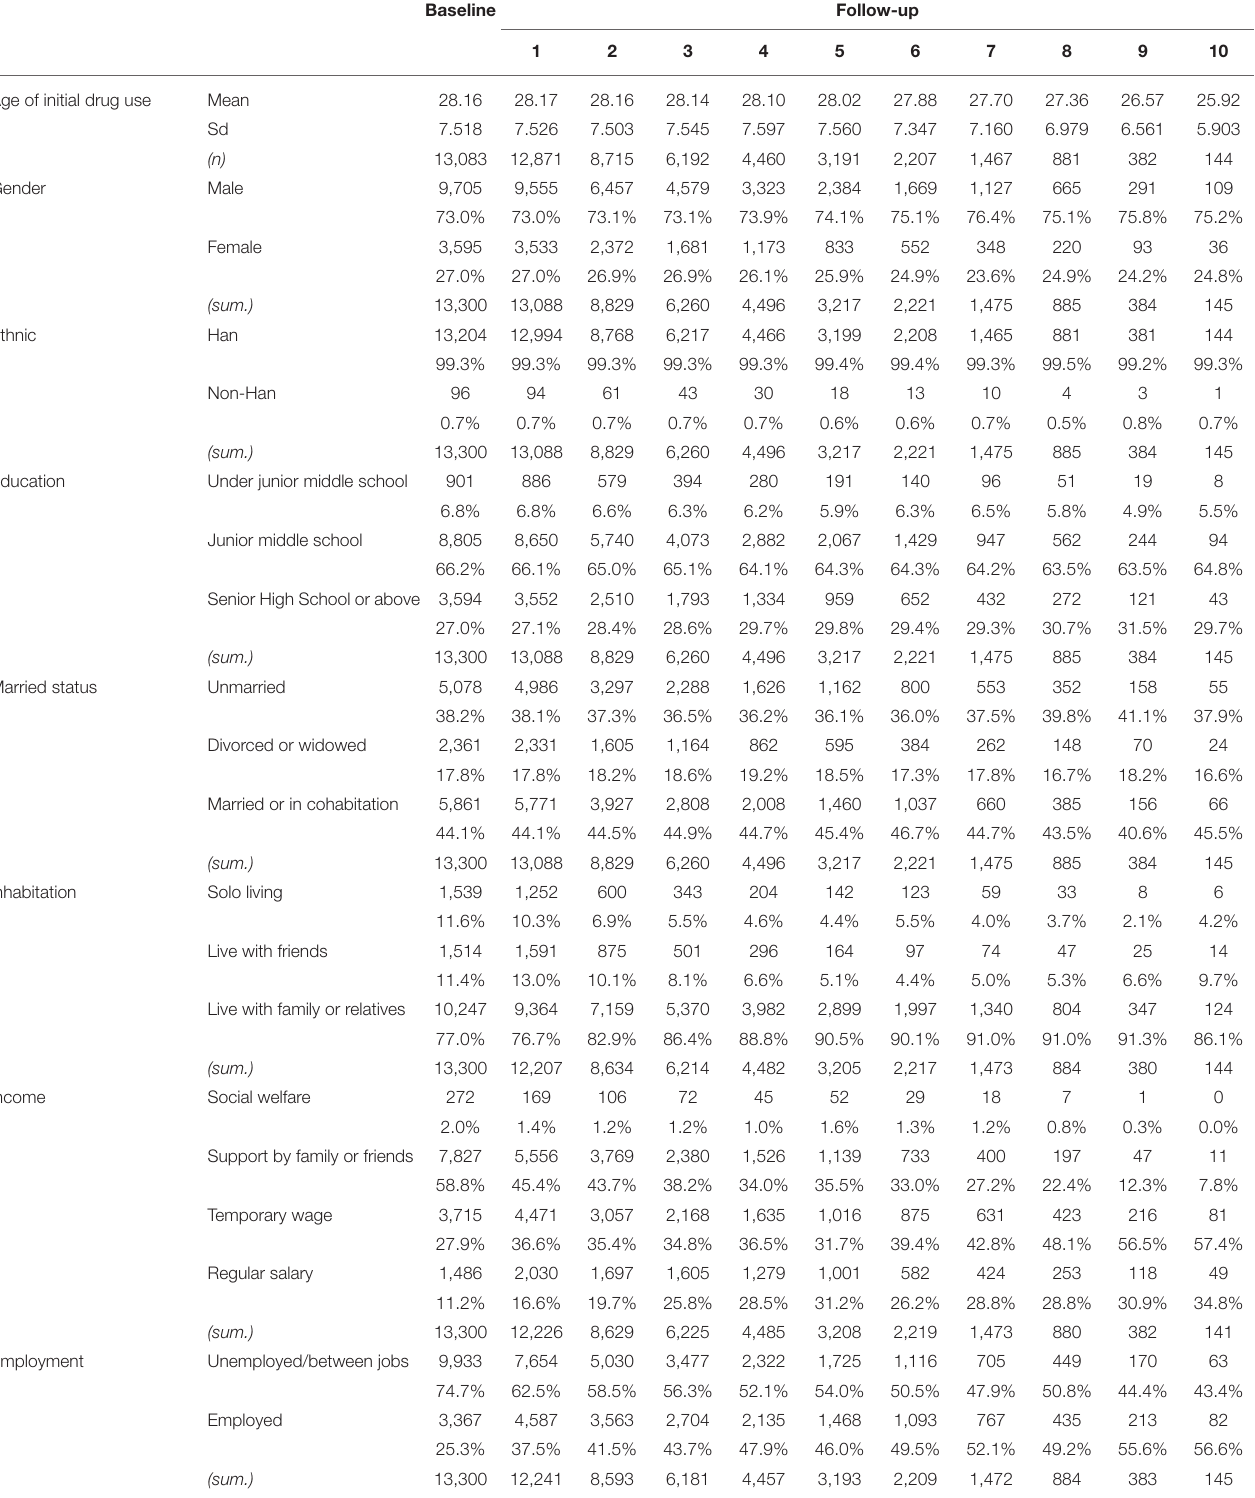
TABLE 1 | Social-demography and HIV/HCV high-risk behaviors of 13,300 PWUD on MMT during 2006–2015, Wuhan, China (mean/n, sd/percentage).